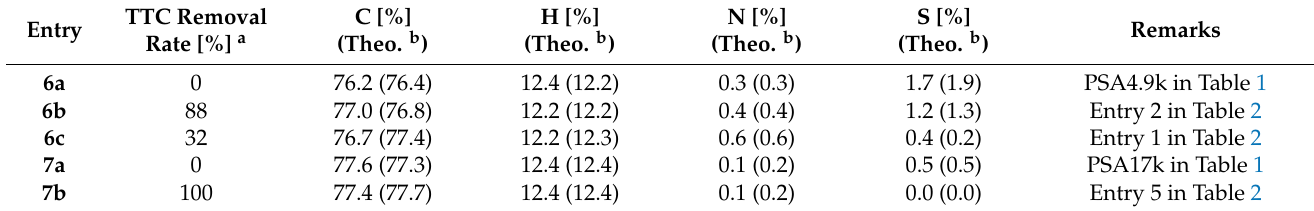
Table 4. Results of elemental analysis for